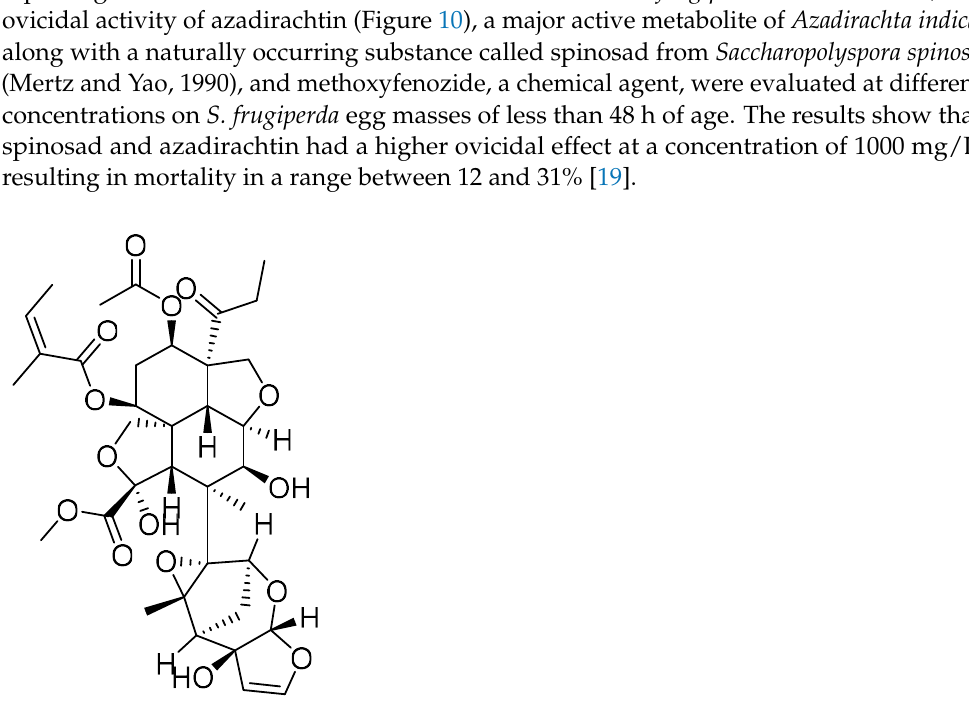
Figure 10. Azadirachtin: a major active metabolite of Azadirachta indica. Azadirachtin belongs to a group of so-called secondary metabolites, limonoids.